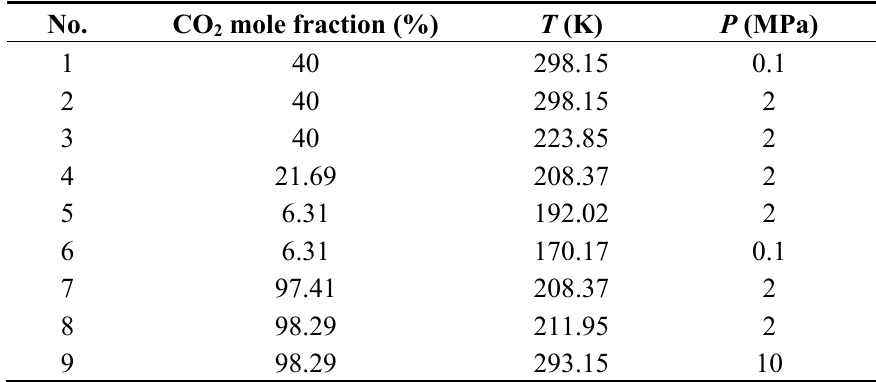
Table 4. The parameters of key state point.